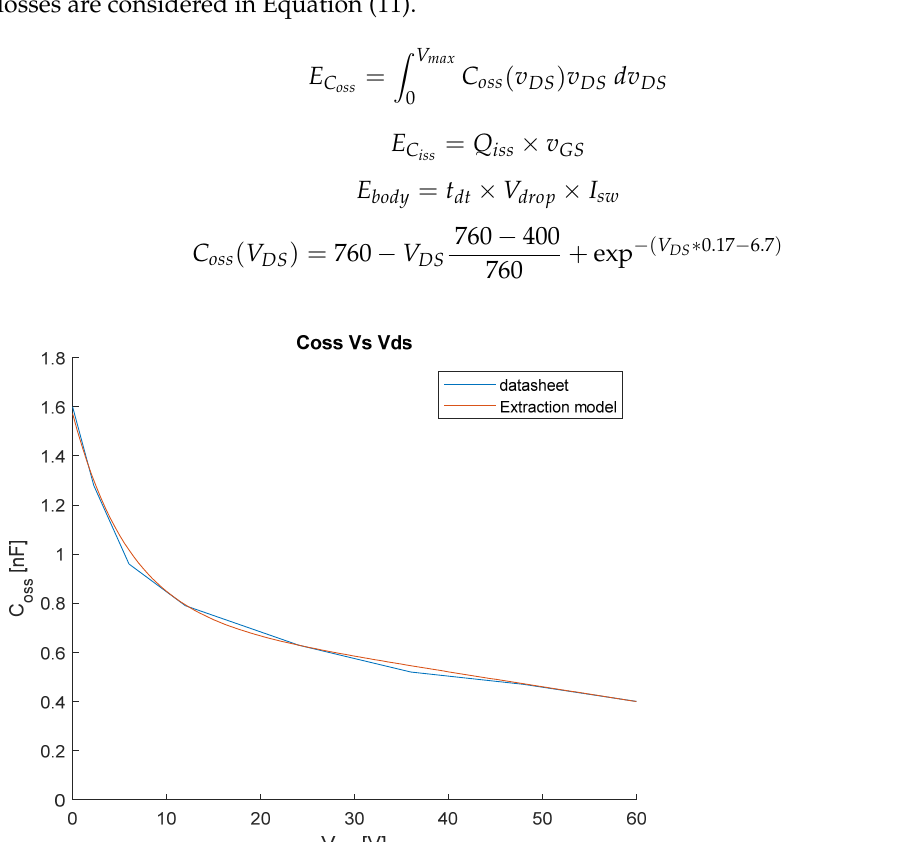
Figure 11. C oss of the transistor SIS862DN-T1-GE3 versus Drain-source Voltage from Equation (12) in red and from component datasheet [25] in bleu.